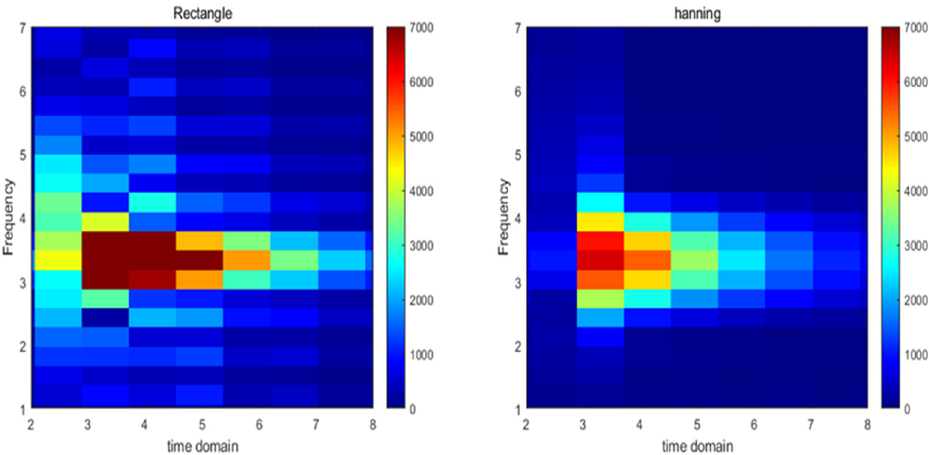
Figure 15. Comparison of Rectangular function and Hanning function.